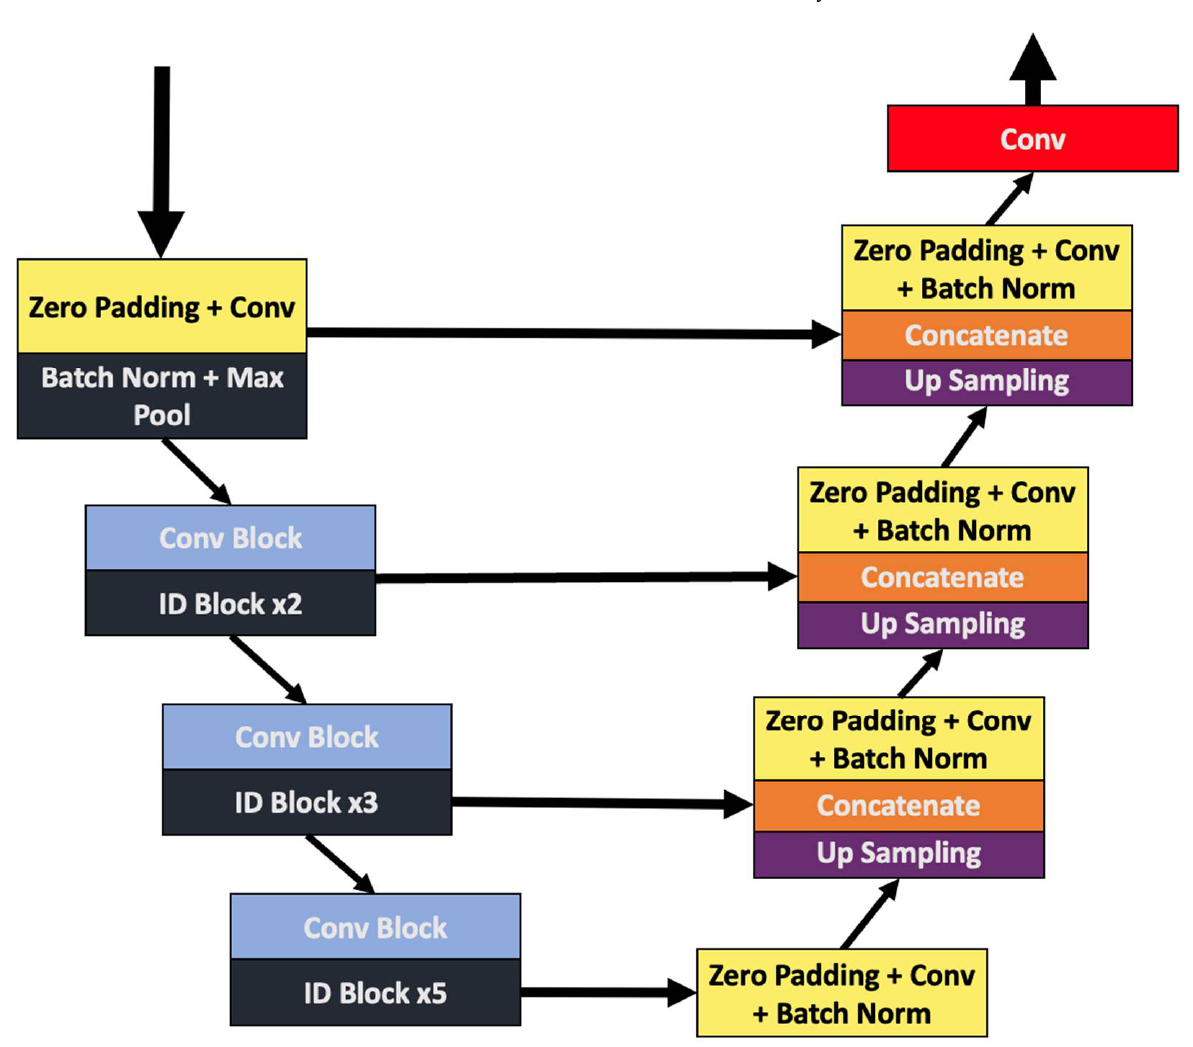
Figure 4. The CNN layers and the direct connections from the encoder ( left side ) to the decoder ( right side ), as illustrated.